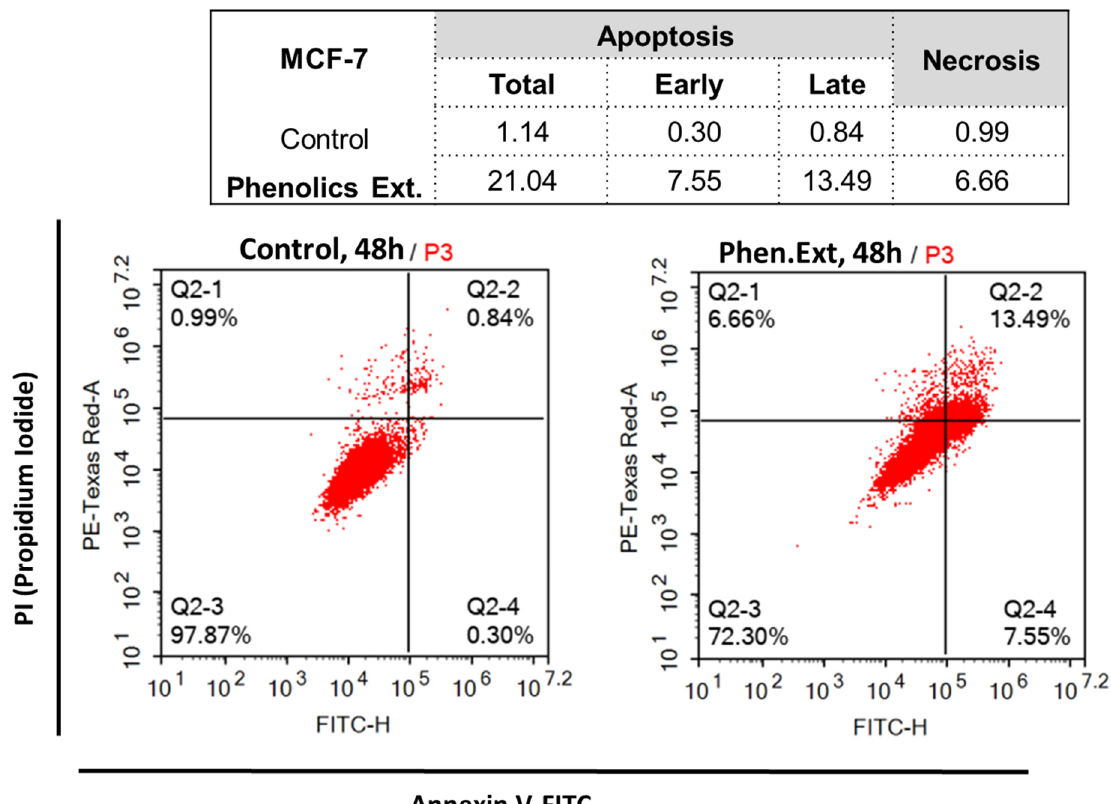
Figure 3. FITC/Annexin-V-FITC/PI differential apoptosis/necrosis of untreated and treated MCF-7 with phenolic extract at IC 50 of 16.67 µg/mL, 48 h. Quadrant charts show Q-2-1 (necrosis, AV–/PI+), Q-2-2 (late apoptotic cells, AV+/PI+), Q-2-3 (normal cells, AV–/PI–), and Q-2-4 (early apoptotic cells, AV+/PI–).